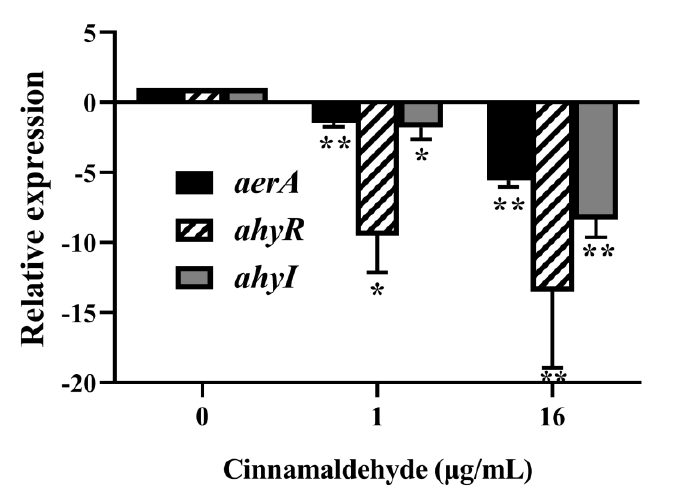
Figure 5. The effects on related genes of A. hydrophila plus cinnamaldehyde. Three independent qPCR assays were performed for aerA , ahyI , and ahyR genes, and the data are mean ± SD. *, 0.01 < p < 0.05 and **, p < 0.01 when compared to drug-free group.